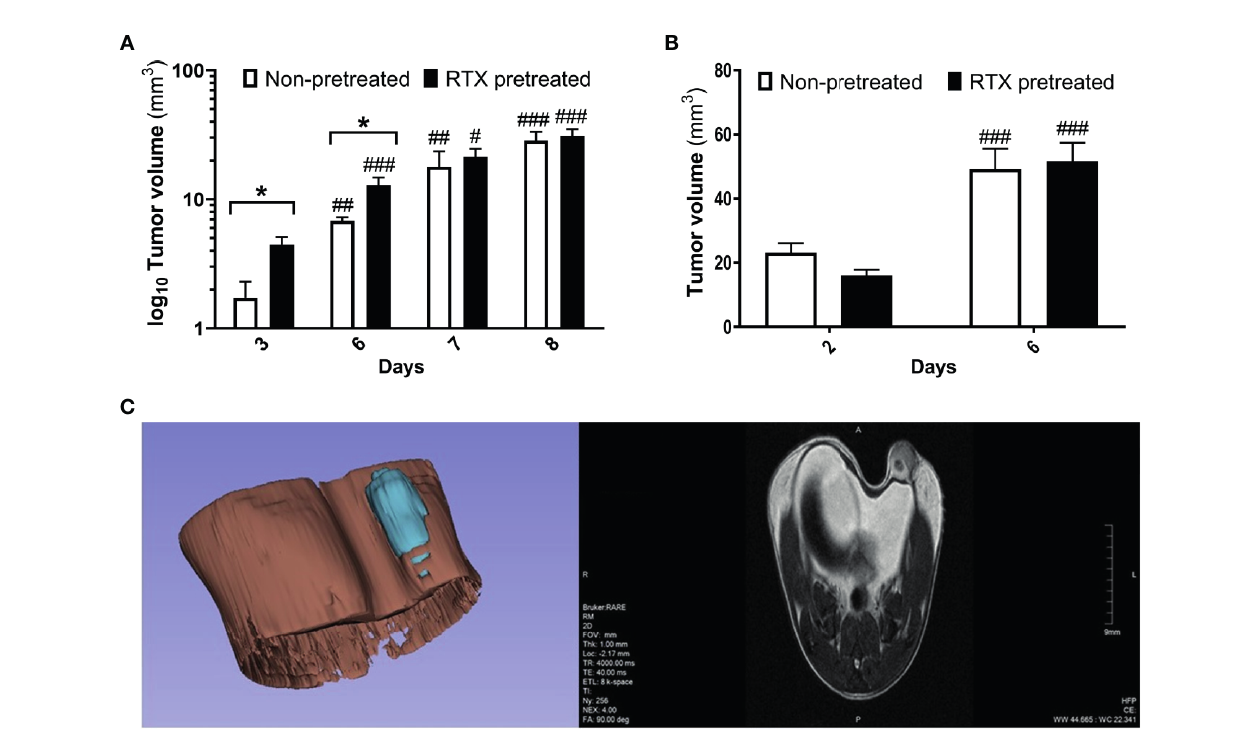
FIGURE 2 | Moderately increased tumor volume in RTX pretreated mice in the early phase postimplantation. (A) Primary 4T1 tumor volume (mm 3 ) and growth in BALB/c mice (n = 10-14 per group, log 10 scale), measured using a digital caliper. (B) Tumor size measurement (mm 3 ) evaluated by high resolution MRI. (n = 10). (C) Representative image of tumor structure (3D volume rendering and one T2-weighted slice in the coronal plane). Tumor volumes were calculated via 3D rendering and measuring. Data were calculated with 3D-Slicer 4.10.2, *p < 0.05 vs . non-pretreated, # p < 0.05, ## p < 0.01, ### p < 0.001 vs . initial measurement of the respective